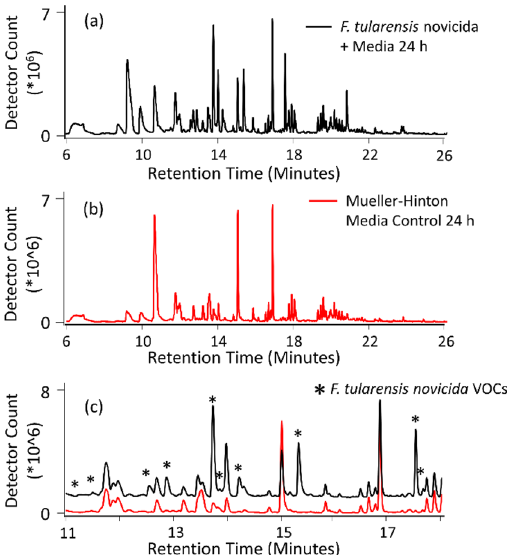
Figure 1. Examples of the chemical complexity exhibited by F. tularensis novicida cultures through comparison of the VOC total ion chromatograms at ( a ) 24 hours post inoculation, ( b ) corresponding Mueller-Hinton media control, and ( c ) overlay of both 1a and 1b over a smaller retention time range to emphasize chromatogram features, where stars indicate the bacteria-specific VOC emissions.